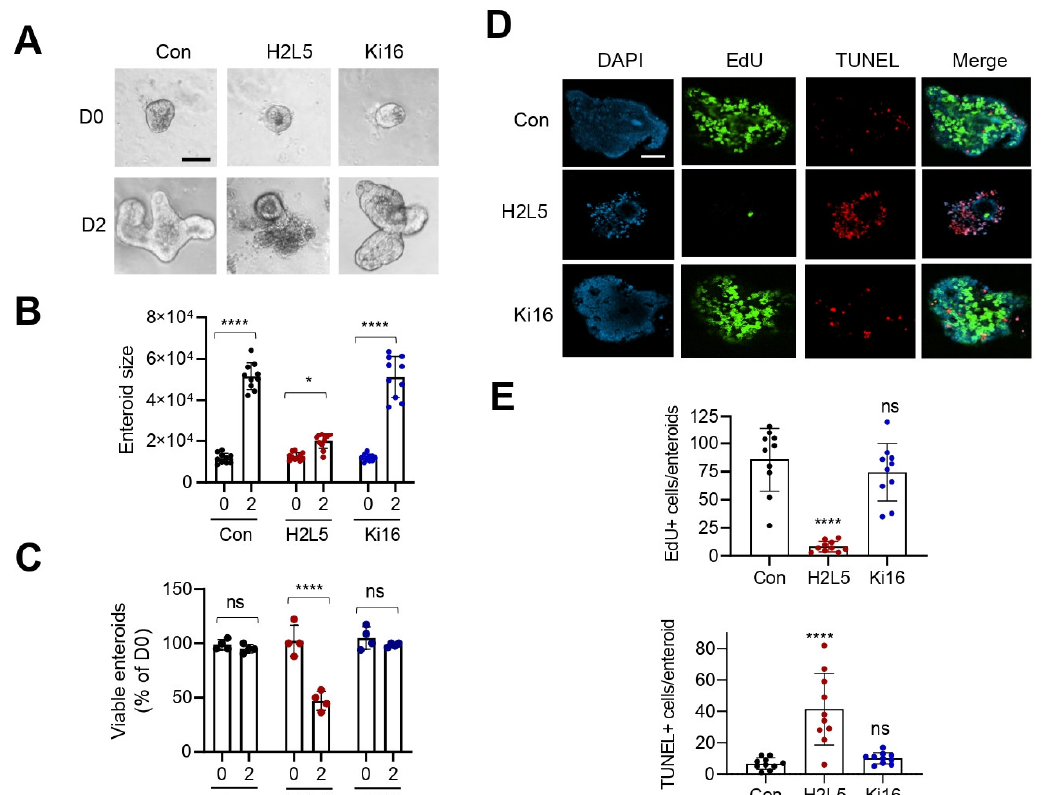
Figure 2. Inhibition of LPA 2 in Lpar5 f/f ;Villi-Cre enteroids results in reduced proliferation and increased apoptosis of IECs. ( A ) Lpar5 f/f ;Villi-Cre enteroids were treated with 10 µ M LPA 2 inhibitor H2L5186303 (H2L5) or LPA 1 /LPA 3 inhibitor Ki16425 (Ki16) on day 0 (D0). Representative images taken on D0 and D2 are shown. n = Bar = 50 µ m. ( B ) The growth of enteroids was quantified by determining the surface area of enteroids using ImageJ. All data are presented as mean ± SD. * p < 0.05, **** p < 0.0001 by two-way ANOVA with Tukey’s multiple comparison test. n = 10. ( C ) Number of viable enteroids counted on D0 and D2 and expressed as percentage on D0. n = 4 wells per condition. **** p < 0.0001, ns = not significant. ( D ) Lpar5 f/f ;Villin-Cre enteroids were treated with H2L5 or Ki. Representative IF images of DAPI (blue), EdU (green), and TUNEL (red) taken on D2 are shown. Bar = 50 µ m. ( E ) Numbers of Edu+ (upper panel) and TUNEL+ (lower panel) cells per enteroid were quantified. n = 10. **** p < 0.0001 and ns = not significant compared with control (Con) by one-way ANOVA with Tukey’s multiple comparison